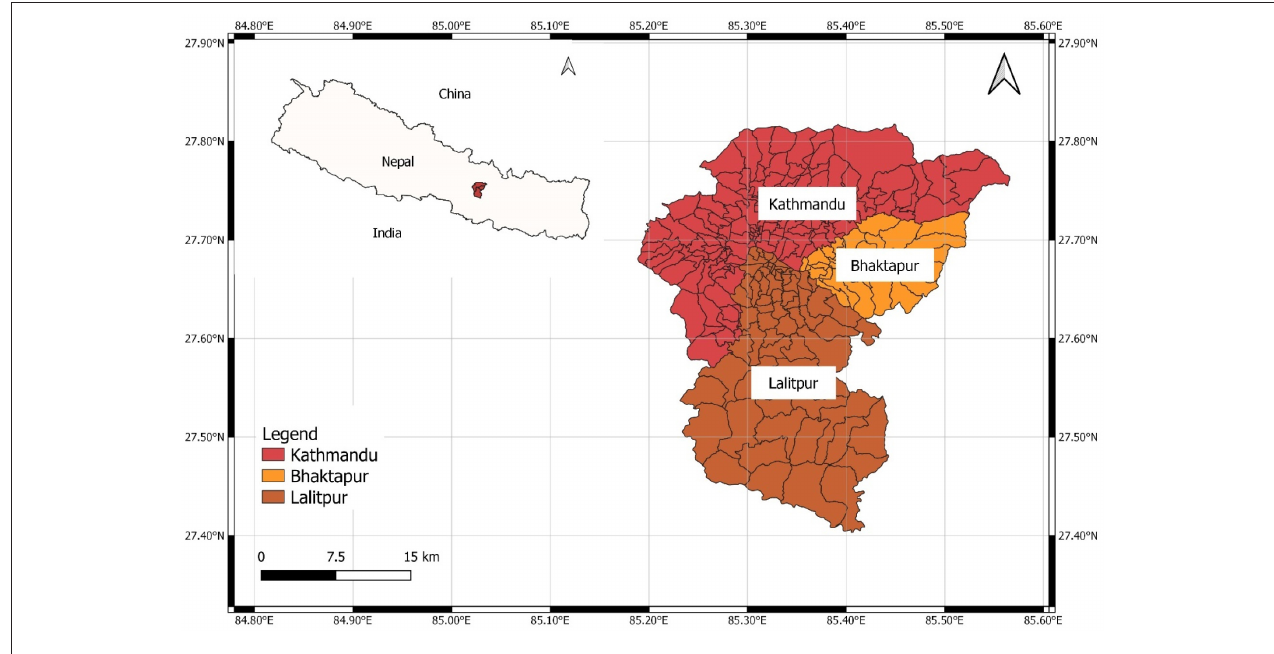
FIGURE 1 | Map of Kathmandu